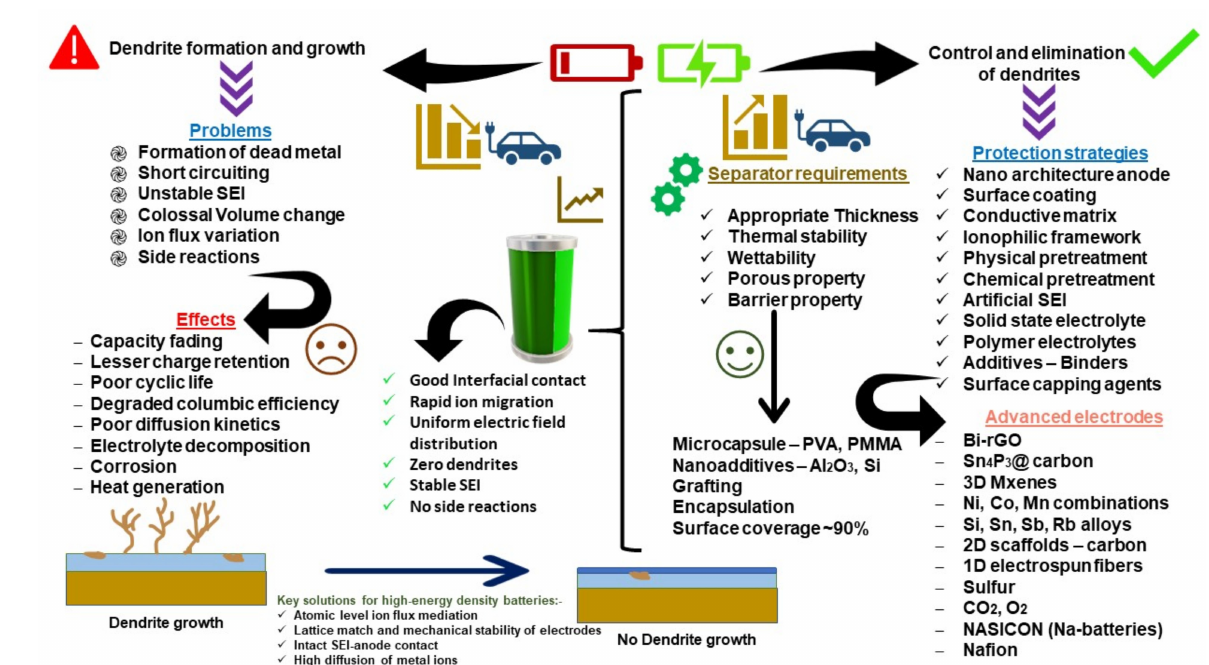
Figure 34. Outline of effects and control strategies for